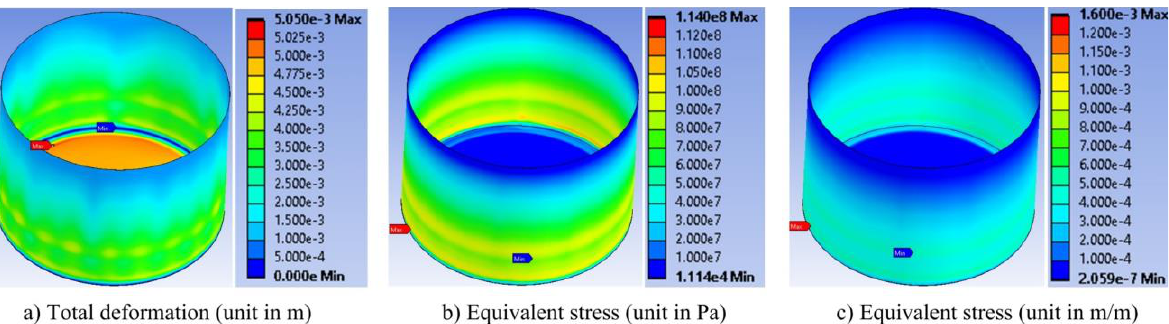
Figure 7 . Finite element results of an oil storage